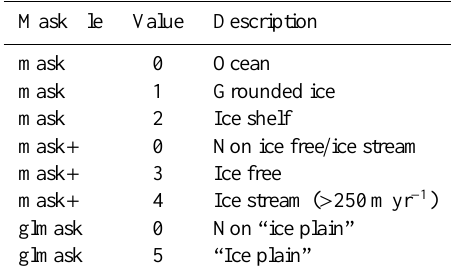
Table 2. Mask values.